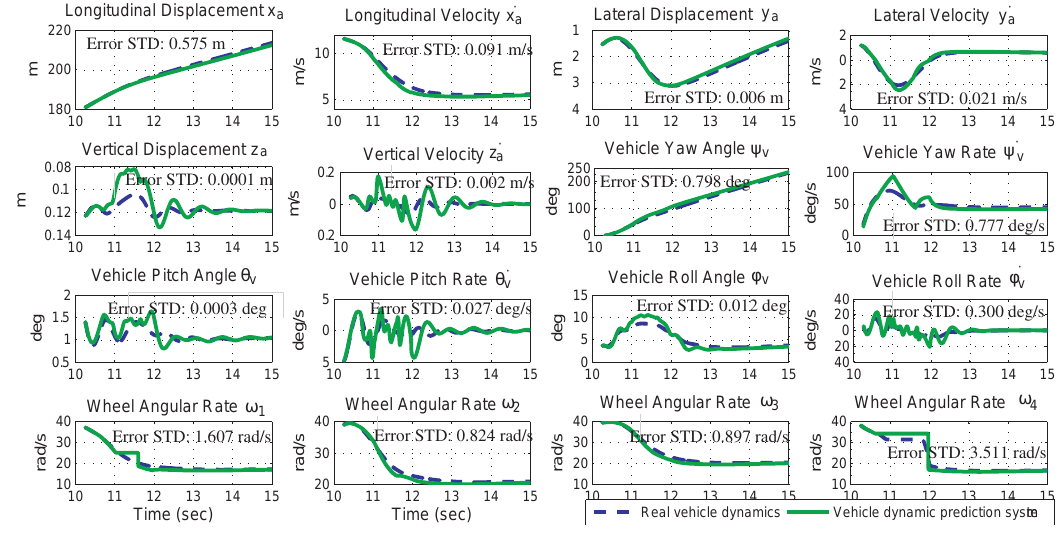
Figure 8. Predictions of the vehicle dynamics in a left-hand turn event. The prediction inaccuracy is 0.51% on average, calculated from the 10.25th second to the 15th second.